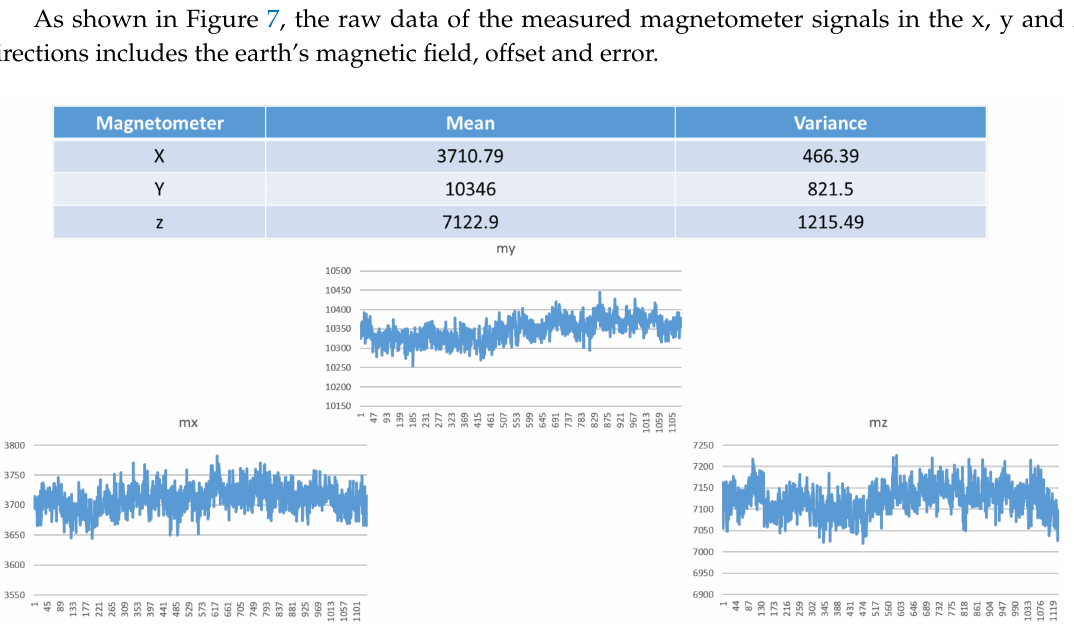
Figure 7. Mean and variance of the magnetometer in the x, y and z